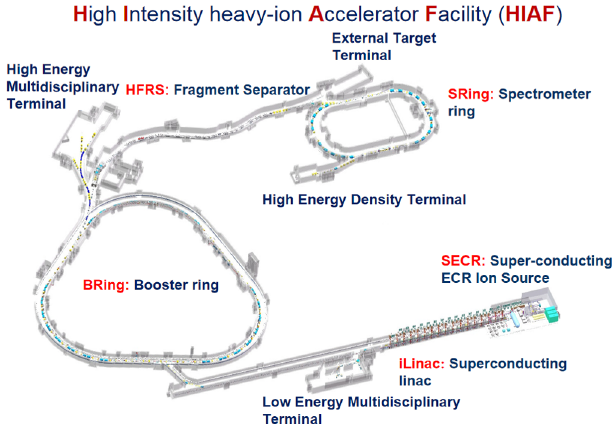
FIG. 1. The general layout of the HIAF